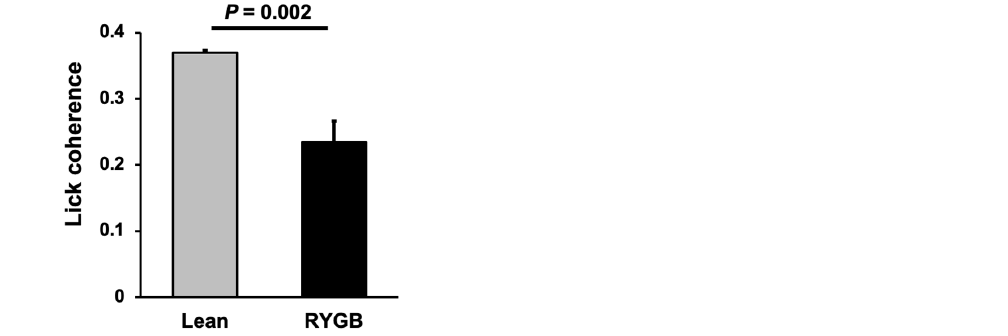
Figure 7. Lick coherence among taste cells. Lean N = 67; RYGB N = 41 taste cells; t = 3.120, df = 106, p = 0.0023, unpaired t test.